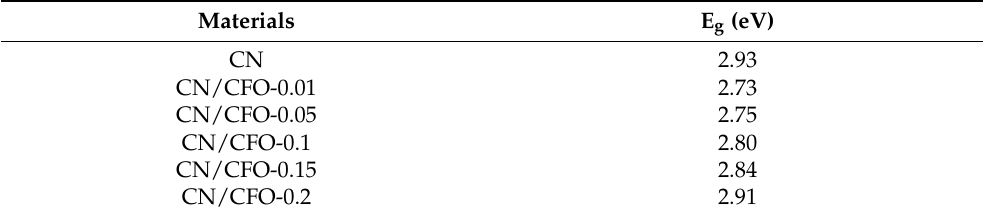
Table 2. Band gap of